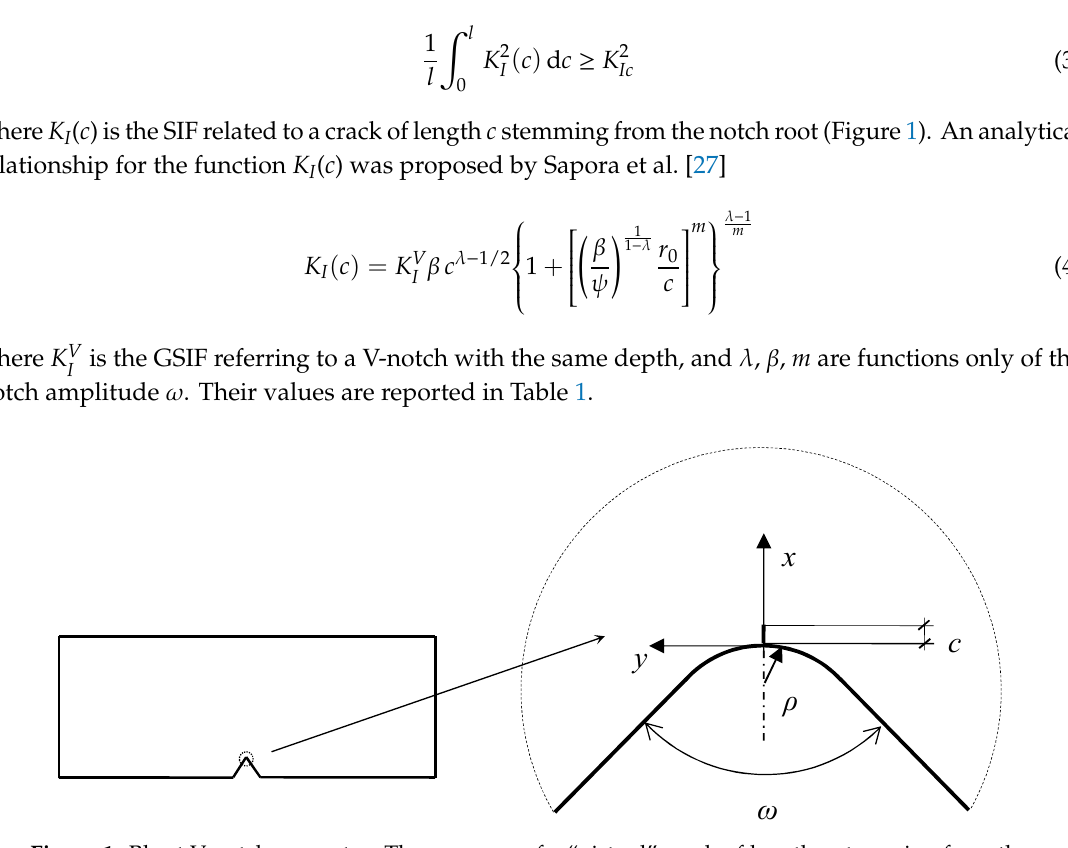
Figure 1. Blunt V-notch geometry. The presence of a “virtual” crack of length c stemming from the notch tip is also depicted. Table 1. Values of different parameters compared to notch opening angle ω.